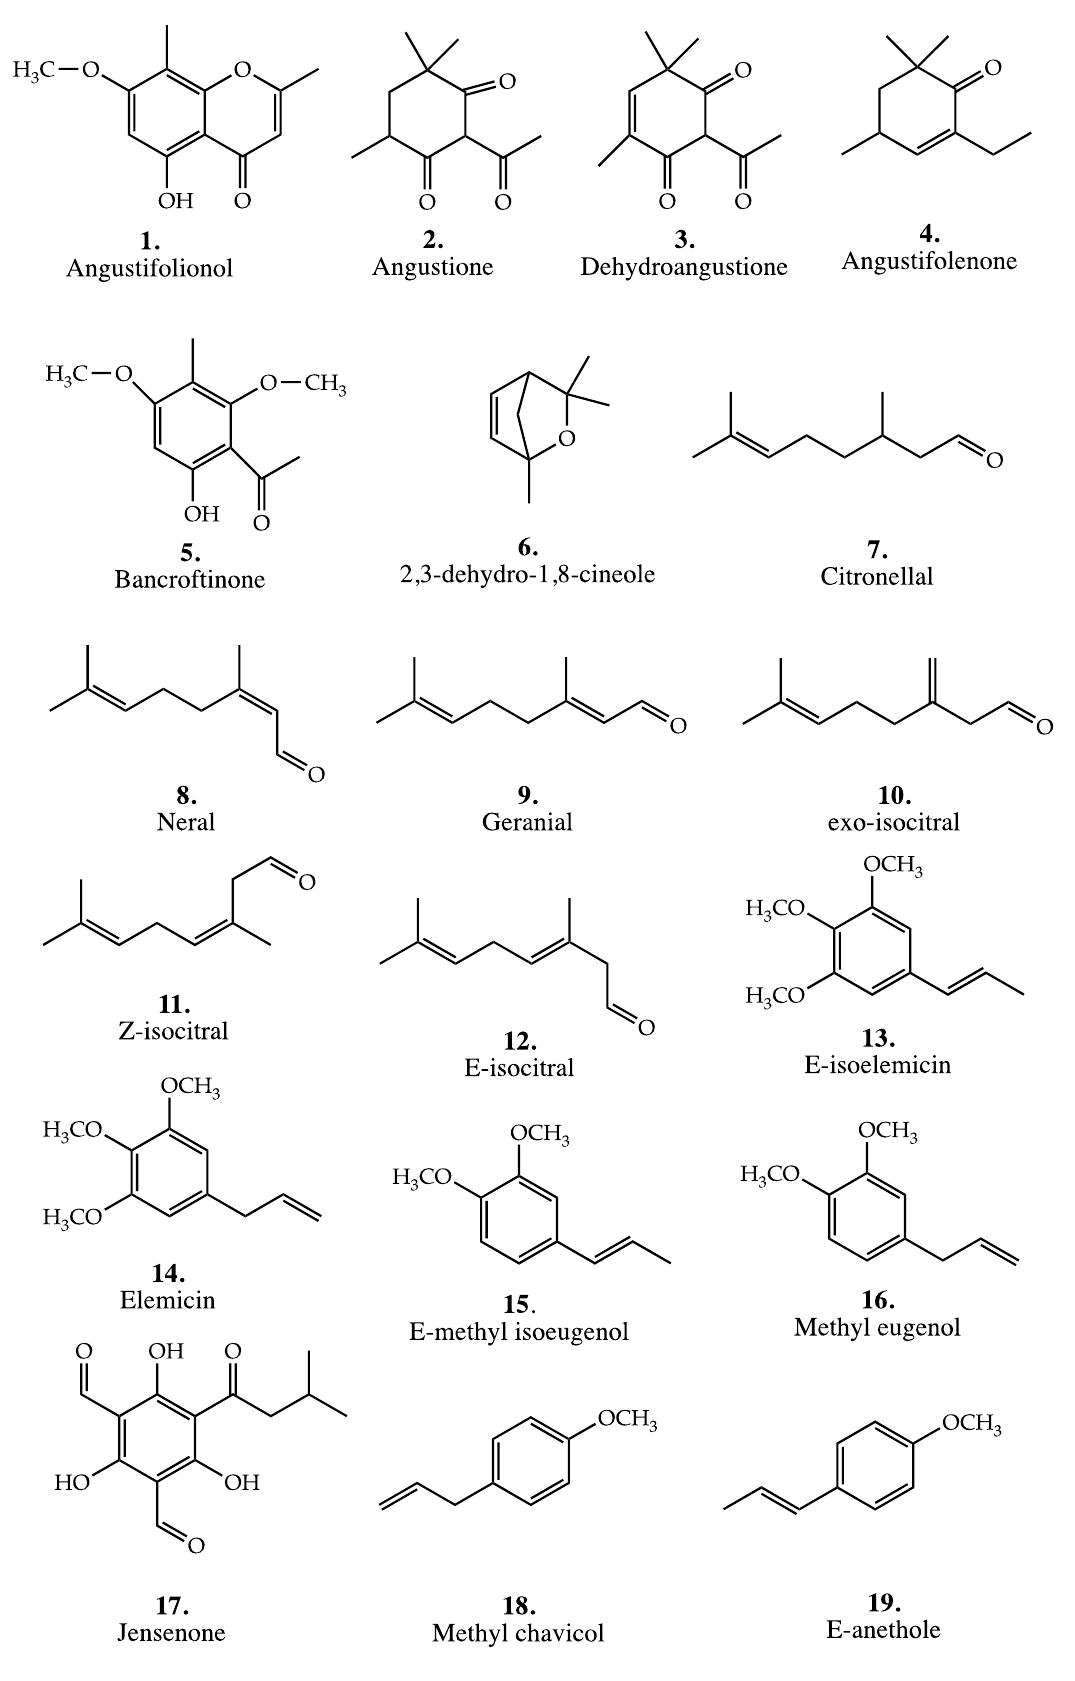
Figure 3. Structures of major or diagnostic compounds mentioned in this review for all Backhousia species.